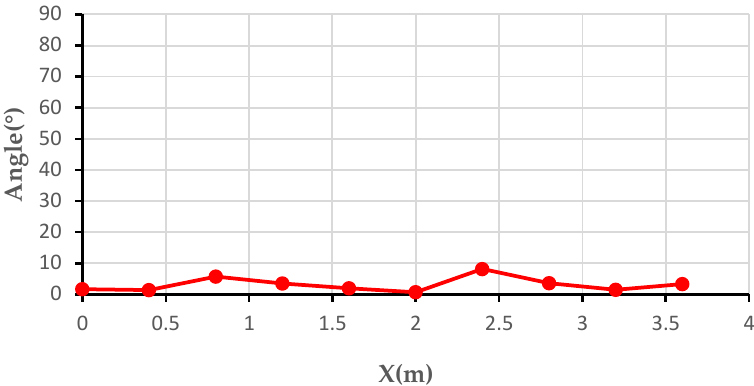
Figure 25. Curve of deflection size of heading angle.